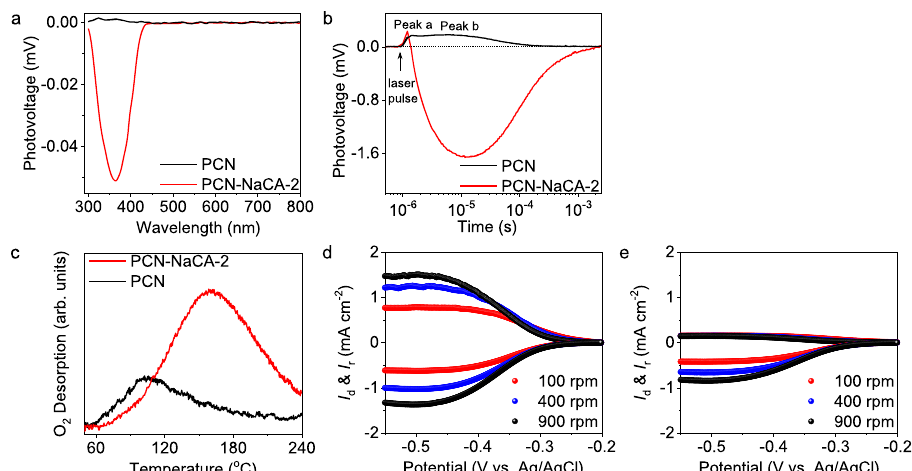
Fig. 7 Behavior of the charges and dioxygen on the surfaces of PCN and PCN-NaCA-2. a Surface photovoltage (SPV) spectra of PCN (black curve) and PCN-NaCA-2 (red curve). b The transient photovoltage spectra of PCN (black curve) and PCN-NaCA-2 (red curve) with 100 μ J 355 nm pulse excitation. c Temperature programmed oxygen desorption (O 2 -TPD) pro fi les of PCN (black curve) and PCN-NaCA-2 (red curve). d , e The linear sweep voltammetry (LSV) plots of PCN-NaCA-2 ( d ) and PCN ( e ) on rotating ring disk electrode (RRDE); I d is the disk current density, and I r is the ring current density divided by collection ef fi ciency. PCN polymeric carbon nitride, PCN-NaCA-2 polymeric carbon nitride with sodium cyanaminate